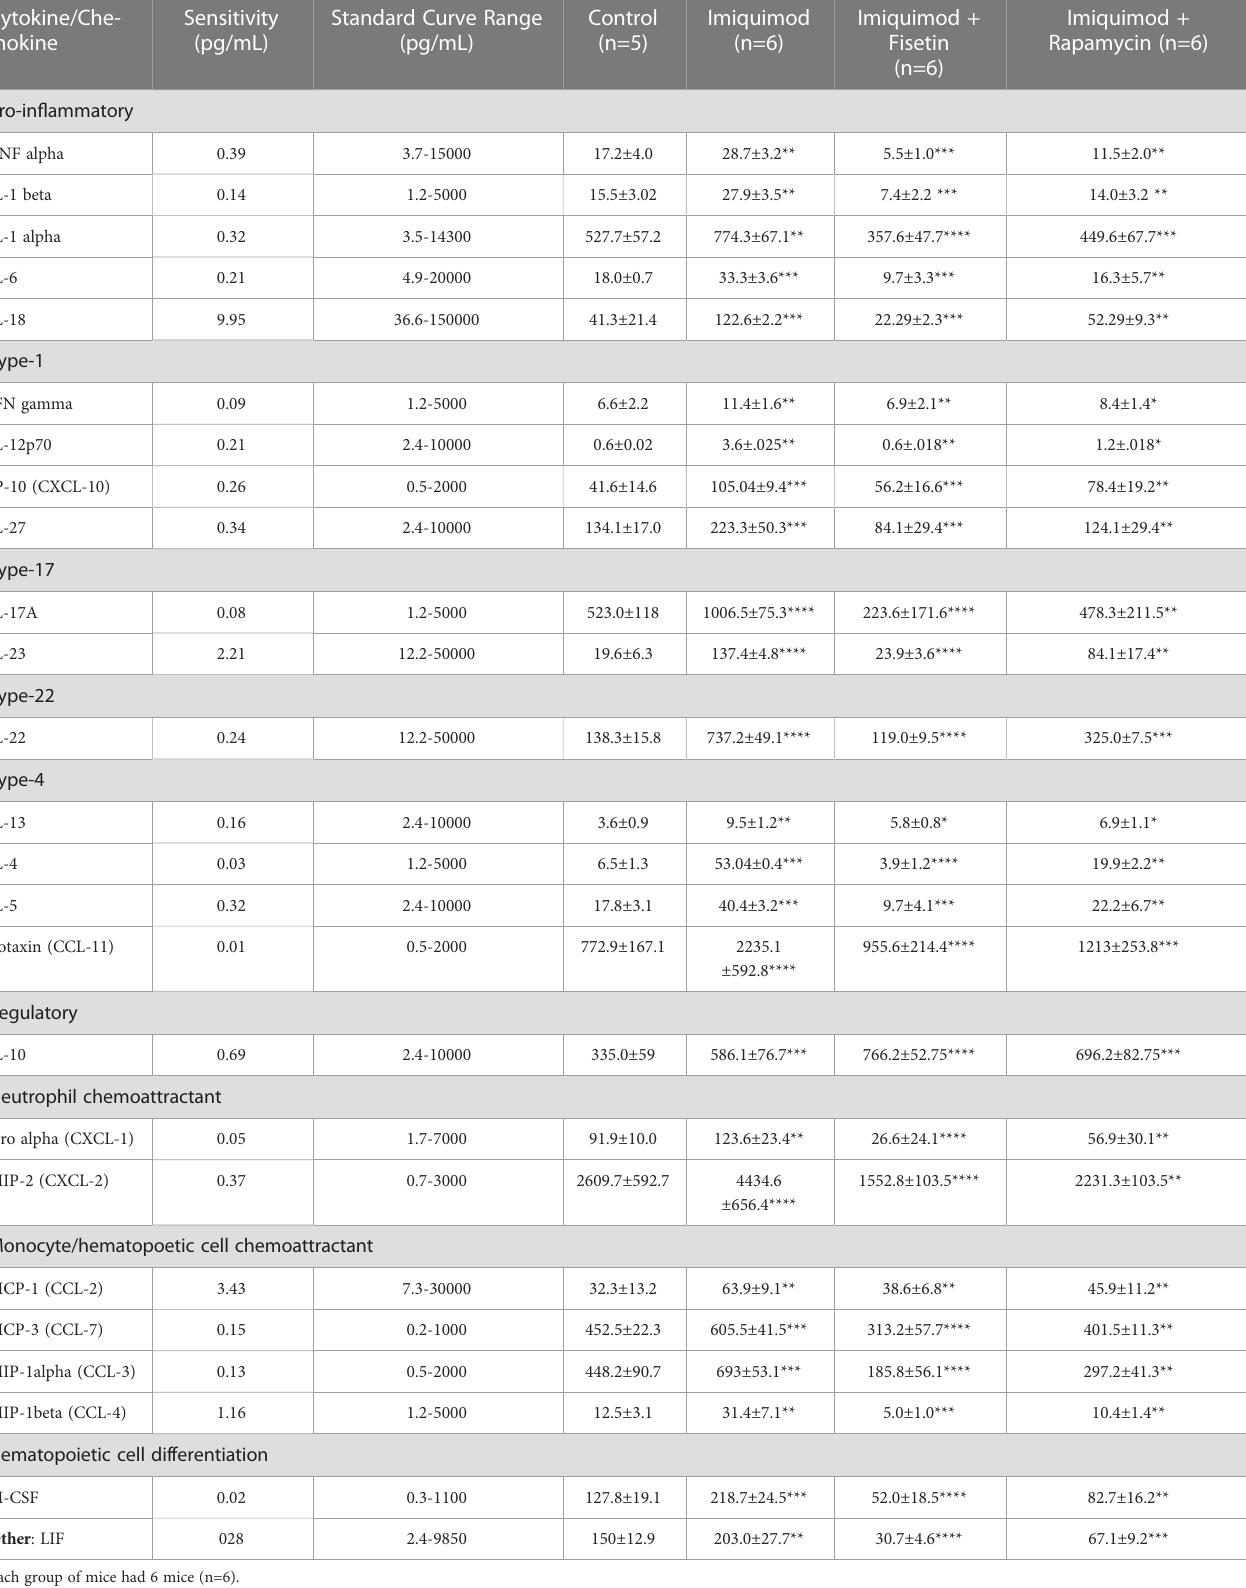
TABLE 1 List of immune mediators that are signi fi cantly modulated upon treatment of IMQ-induced mice skin lesions with fi setin or rapamycin. Each group of mice had 6 mice (n=6) and control group was n=5. Cytokine/Che-